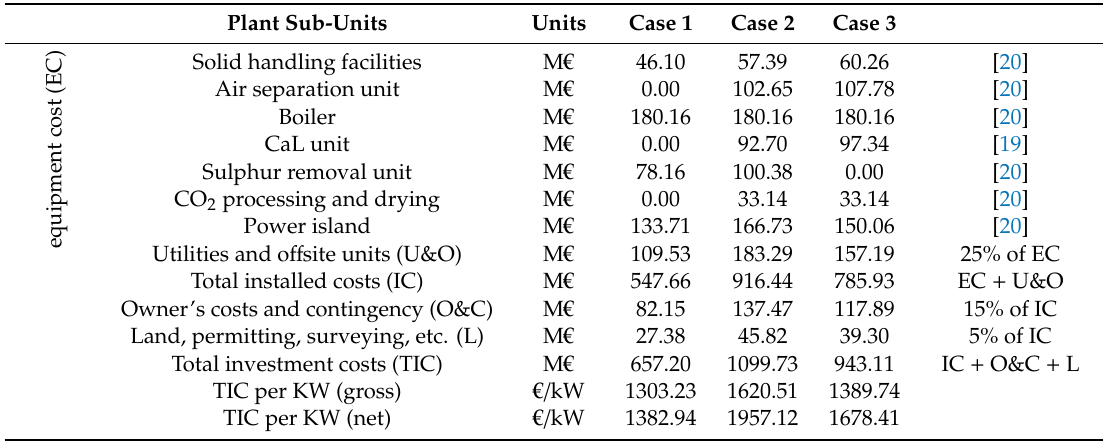
Table 3. Estimation of capital costs and total investment cost per kW.